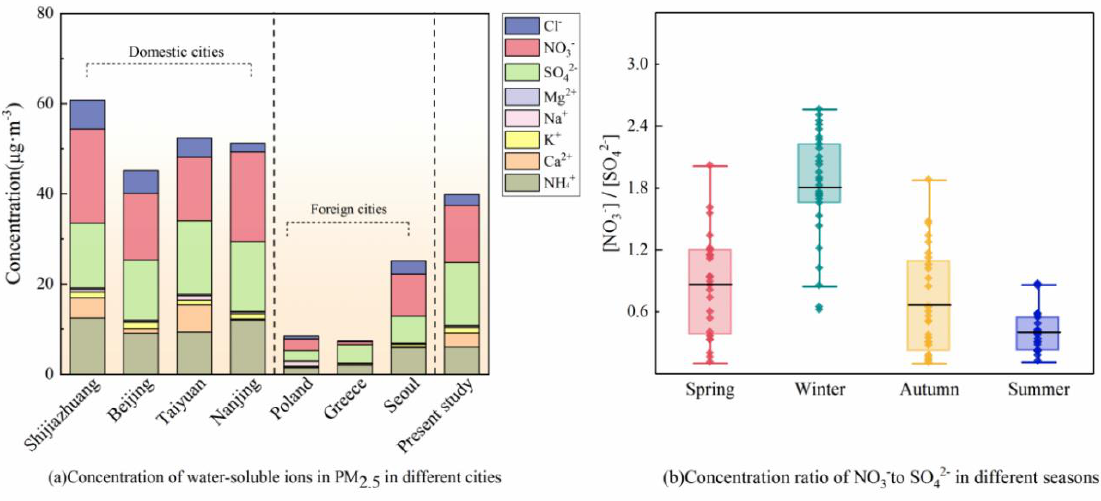
Figure 5. Concentrations of water-soluble ions in PM 2.5 in different cities and seasons. It can be observed that compared with some European cities, such as Poland and Greece [44–46], the concentrations of water-soluble ions in PM 2.5 are generally higher in some Asian cities, including Beijing [47], Shijiazhuang [48], Nanjing [49], and Seoul [50]. This phenomenon shows that the air pollution level in Asia is more serious than that in Europe. When compared with other Chinese cities, the concentration of total water-soluble ions in PM 2.5 in Xinxiang City is lower but with higher concentration levels of NO 3 − and SO 42 − , which is close to Shijiazhuang, Taiyuan, and other cities. This indicates that the air condition may be greatly affected by human activities, and the concentration of secondary ions in particulate matter is high. The ratio of NO 3 − and SO 42 − in atmospheric particles can evaluate the impact of fixed and mobile sources on the atmospheric environment [51]. When (NO 3 − )/(SO 42 − ) > 1, it indicates that the influence of mobile pollution sources is higher than that of fixed pollution sources; when (NO 3 − )/(SO 42 − ) < 1, it indicates that the contribution of fixed pollution sources is greater than that of mobile pollution sources. During the sampling period, the ratio of NO 3 − to SO 4 2 − varied from 0.10 to 2.56, with the lowest ratio in summer and the highest ratio in winter, with an average of 1.81, indicating that the contribution rate of mobile pollution sources in winter in Xinxiang City is higher than that of fixed pollution